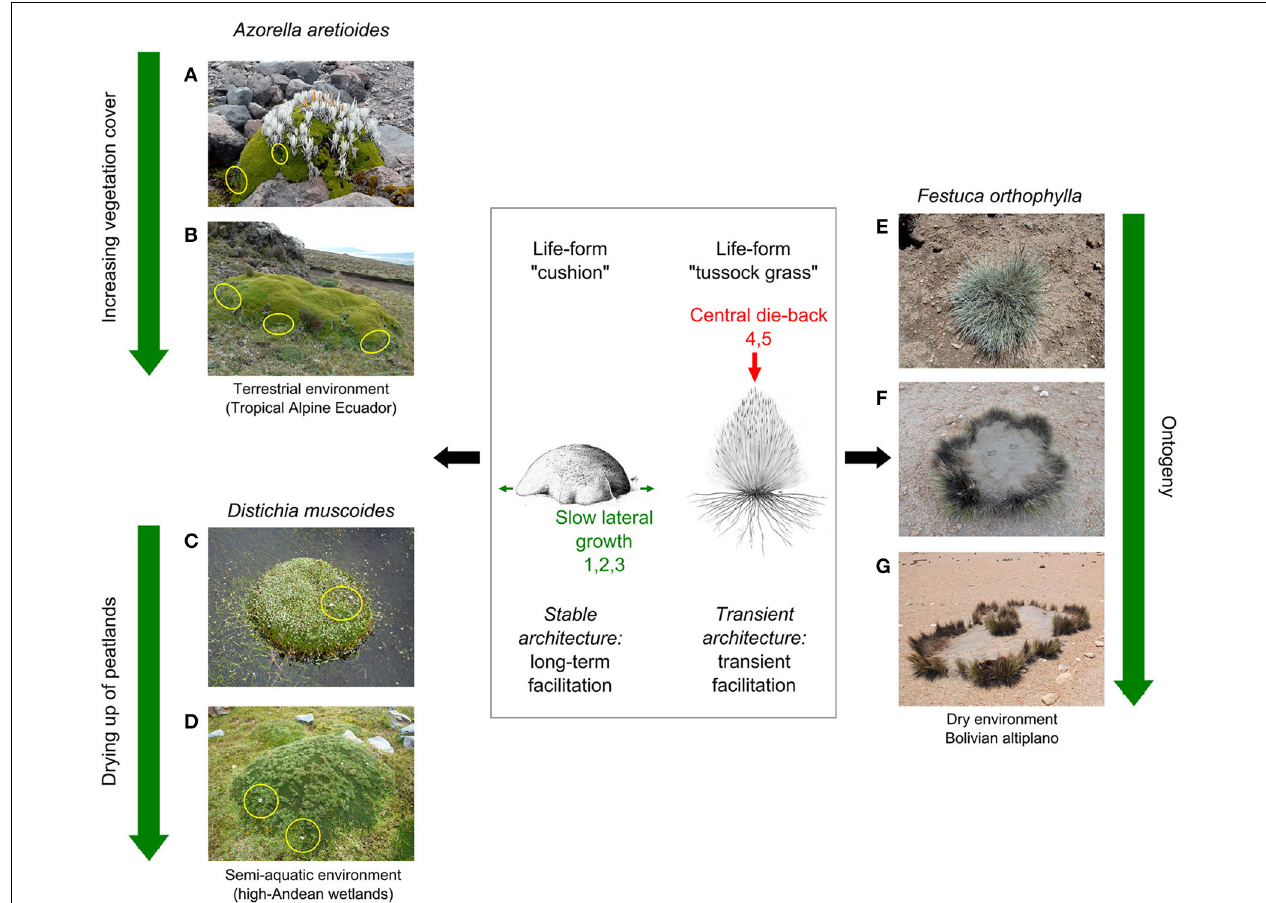
FIGURE 6 | Two distinct alpine life forms expected to generate two interaction outcomes under the effects of climate change. On the left, cushion-forming plants: (A,B) Azorella aretioides in terrestrial environments, with the alpine beneficiary Hypochaeris sessiliflora observed both during the first steps of primary succession and long after, when vegetation cover at the soil surface approaches 100% (red circles; Anthelme et al., 2012); (C,D) Distichia muscoides in semi-aquatic environments, with the beneficiary species Gentiana sedifolia (light blue flowers, yellow